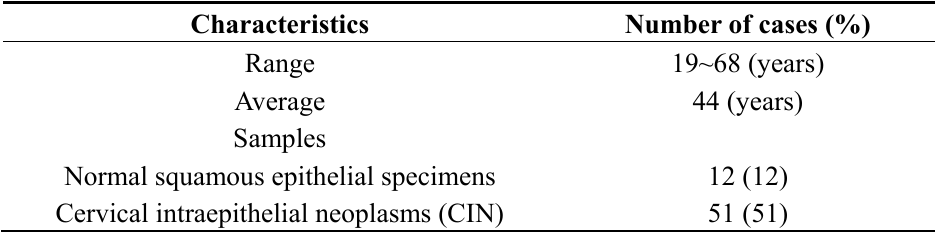
Table 1. Clinical and pathological